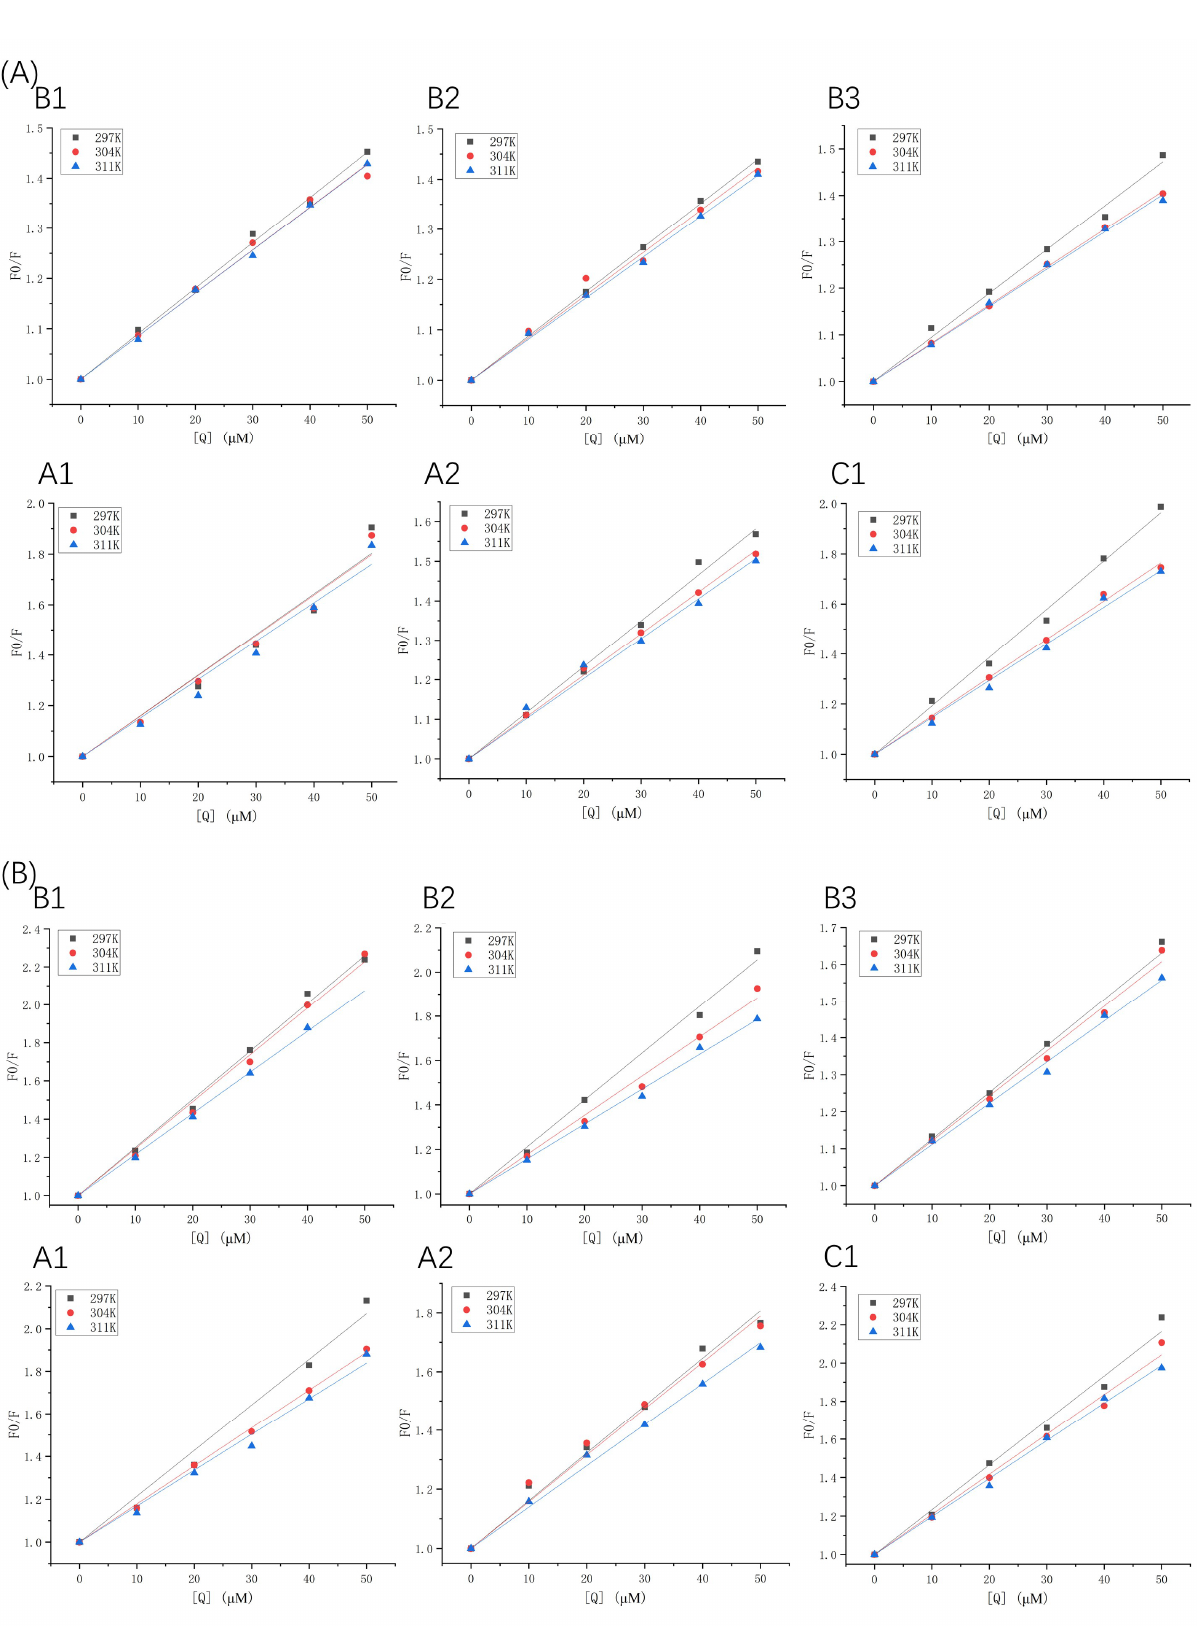
Figure 2. Stern–Volmer plots of β -LG ( A ) or α -LA ( B ) quenched by proanthocyanidins A1, A2, B1, B2, B3, and C1 at 297 K, 304 K, and 311